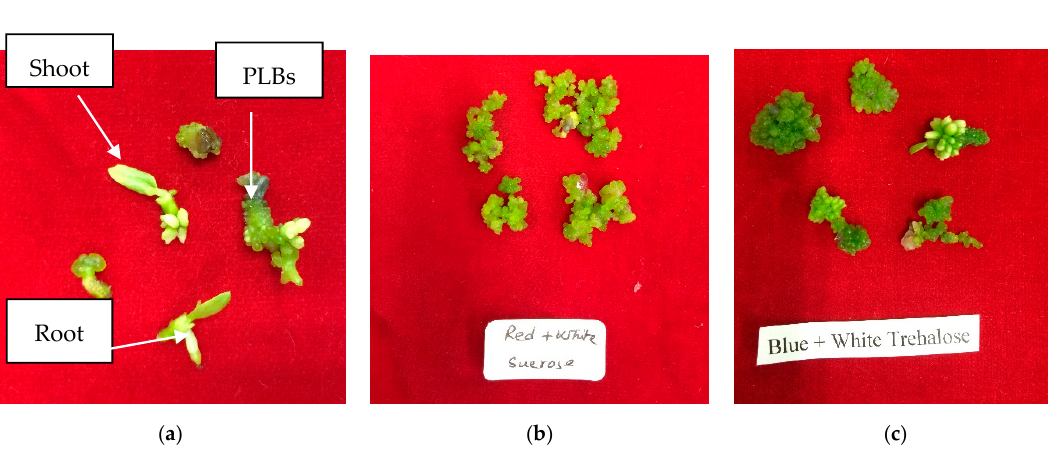
Figure 1. PLB organogenesis of Phalaenopsis : ( a ) PLBs, shoots, and roots, ( b ) RW-sucrose; and ( c ) BW-trehalose.